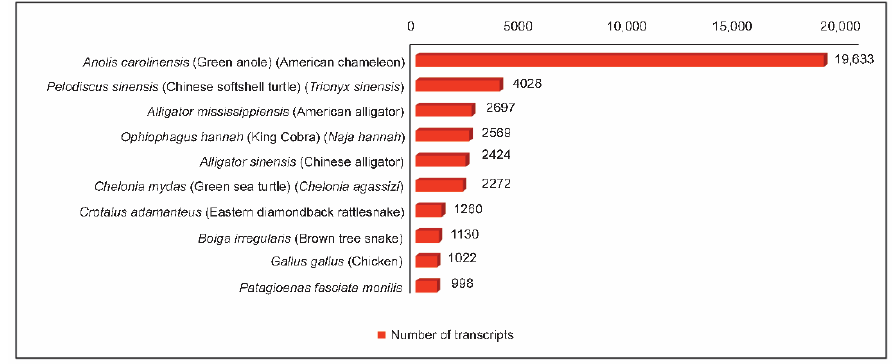
Figure 2. Top ten organisms and the number of transcripts from them in BLASTX hits.